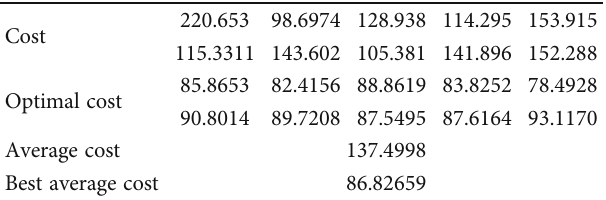
Table 5: Statistics of cost and optimal cost at di ff erent times.